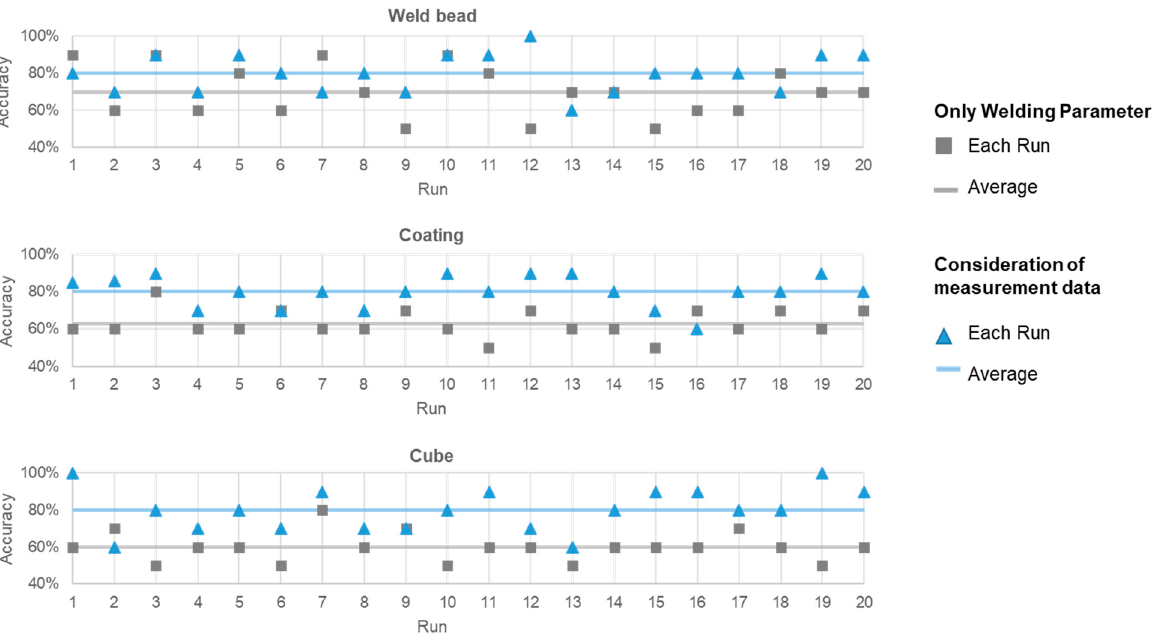
Figure 4. Accuracies and average values of the runs for each geometry